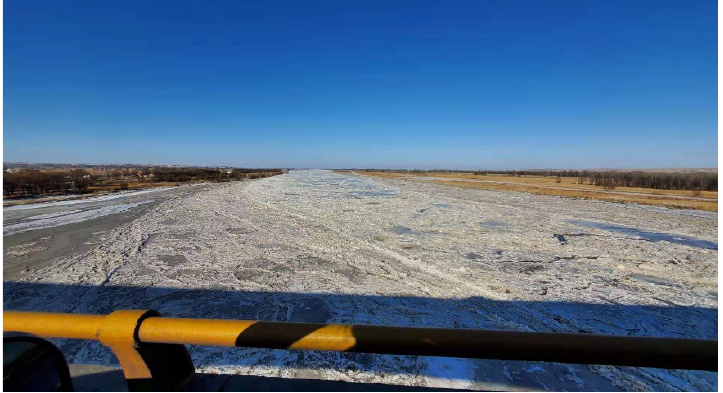
Figure 13. A section of the Yellow River during a stable ice-covered period.